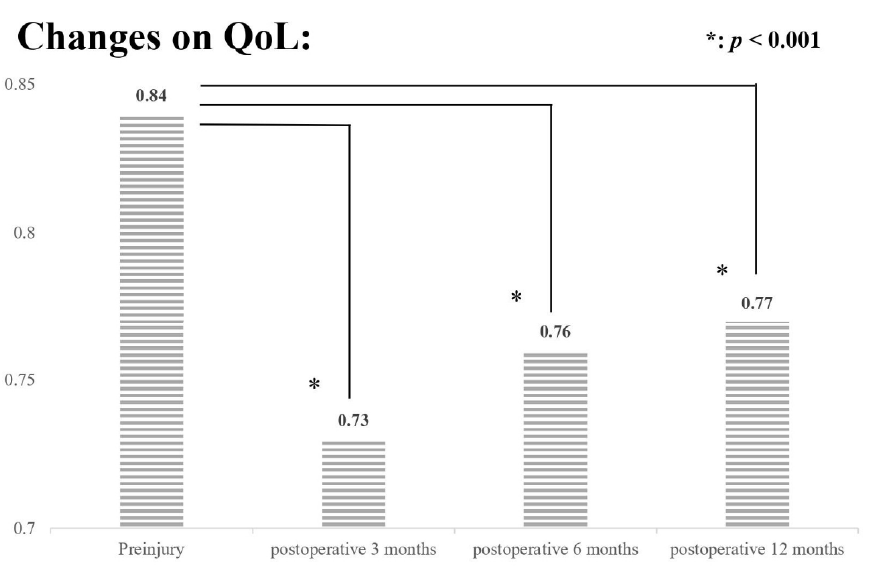
Figure 1. Consecutive QoL (EQ-5D) measurements at preinjury, 3, 6, and 12 months after hip fracture repair surgery. *: p < 0.001.